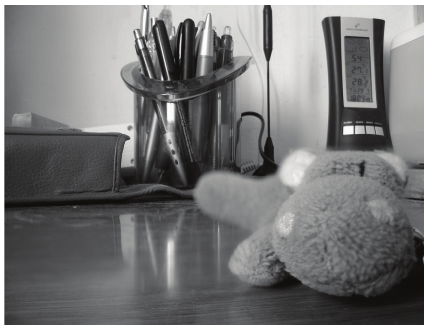
Figure 9: Table—the ESA fusion of the image “Table,” 2 input images, approximate run time: 10 sec.